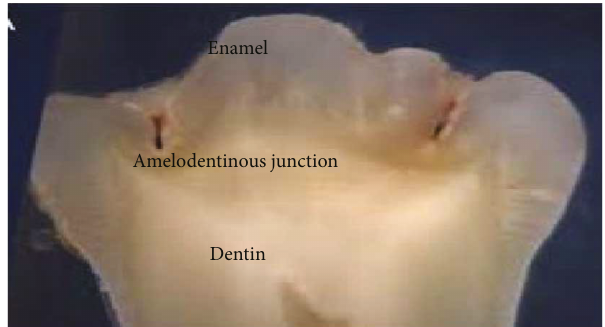
Figure 1: Sagittal section of a molar where the amelodentinous junction is observed.